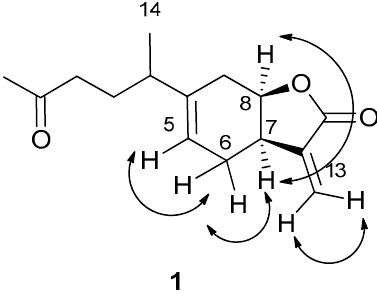
Figure 2. Correlations observed in the NOESY spectrum of inuloxin E ( 1 ).